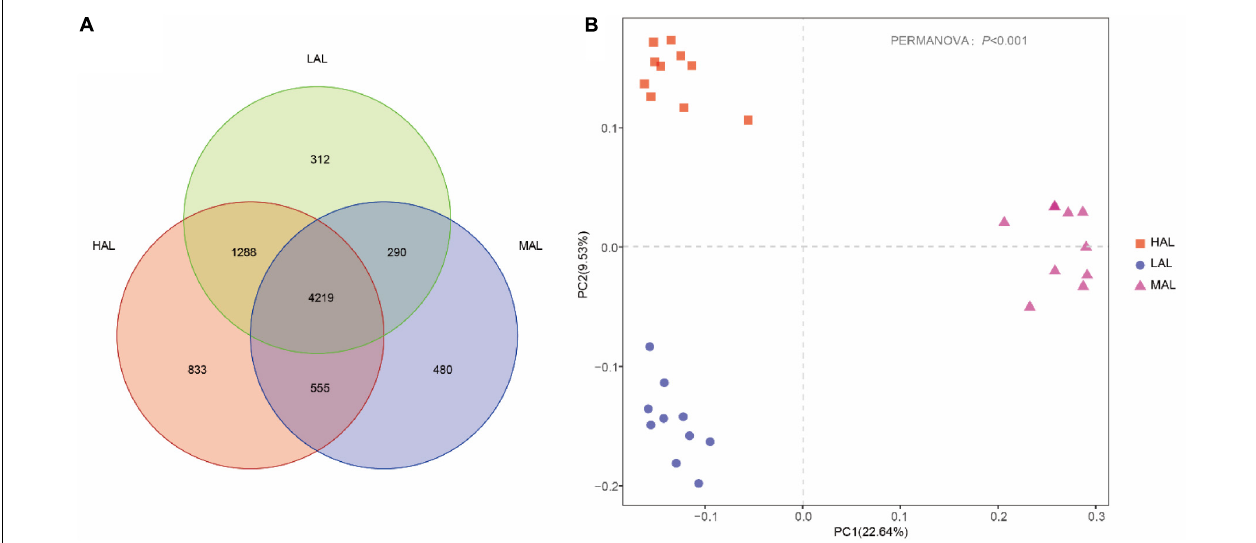
FIGURE 1 | Response of rumen microbiota from yaks among the three regions. (A) Composition of rumen microbiota from yaks inhabiting regions located at distinct altitudes (OTU-level analysis). (B) PCoA analysis of rumen microbiota from yaks inhabiting regions located at distinct altitudes. HAL, high-altitude region (Zhongba